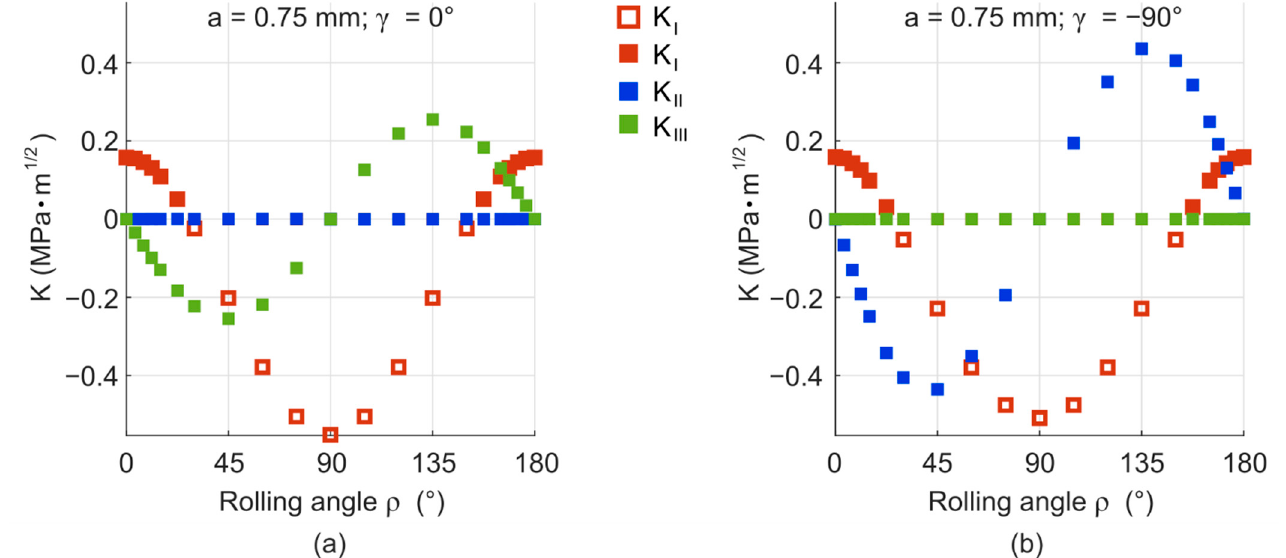
Figure A2. Course of stress intensity factors during rotation in the cylinder D × L = 6 × 6 mm 2 , load F = 350 N, a = 0.75 mm, position on the crack front; ( a ) γ = 0°; ( b ) γ = − 90°.